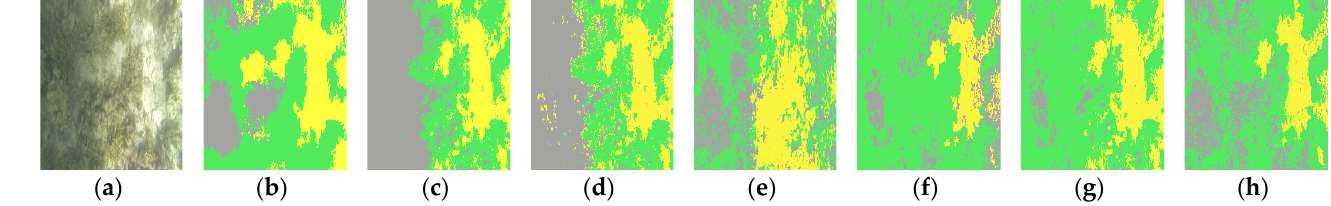
Figure 8. Validation tests of the proposed segmentation algorithms using low illuminated and high contrast algae image (14) from Figure 4 as example of three categories: ( a ) original image; ( b ) ground truth image; ( c ) KM result; ( d ) KMAc result; ( e ) FFCr result; ( f ) FRCr result; ( g ) OSCr result; ( h ) KMCr result. Green: algae, gray: corals, and yellow: sediments.